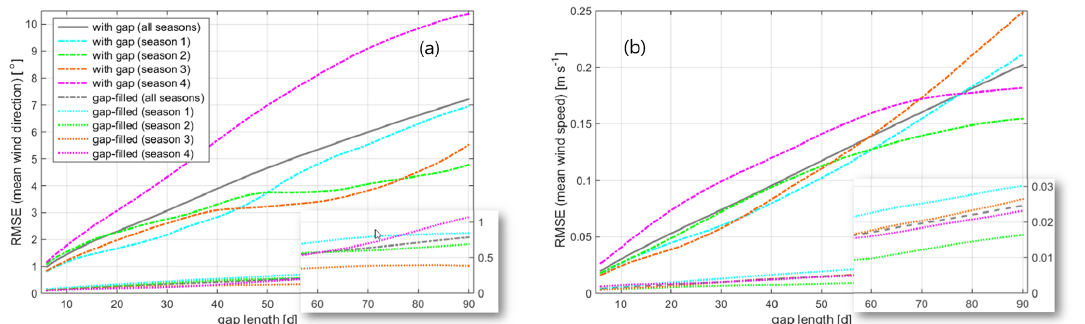
Figure 10. Dependency of impact of data gaps, quantified as RMSE, on the length of the data gaps and season (defined according to the gap start date) – as in Fig. 9 but here only for (a) mean wind direction and (b) mean wind speed. Results exemplarily for